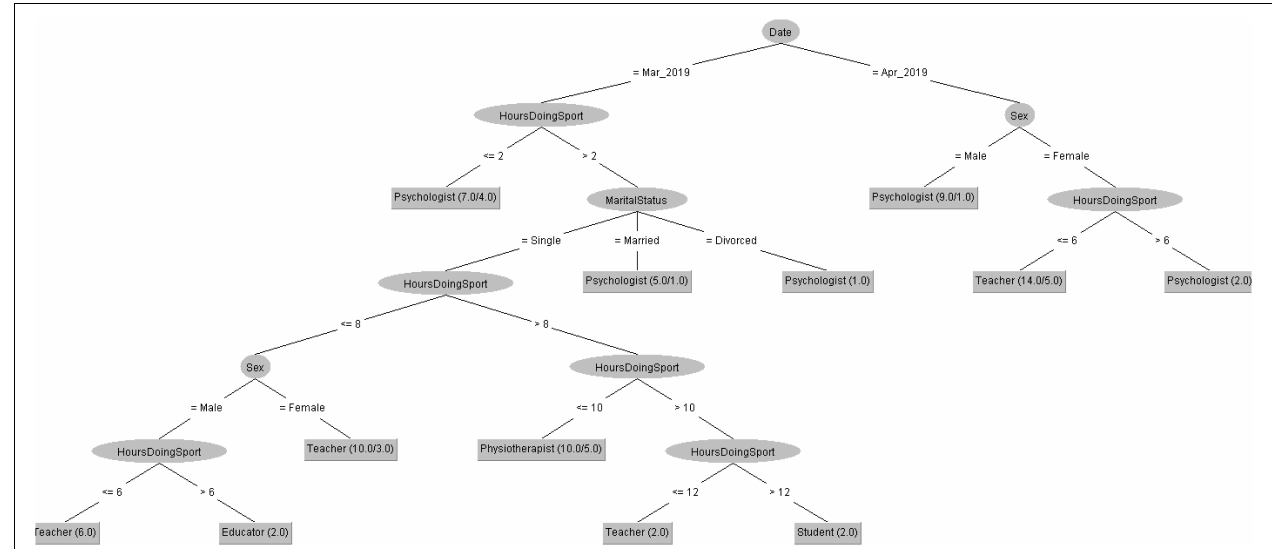
FIGURE 15 | Profession of people taking the MBI questionnaire in 2019 decision